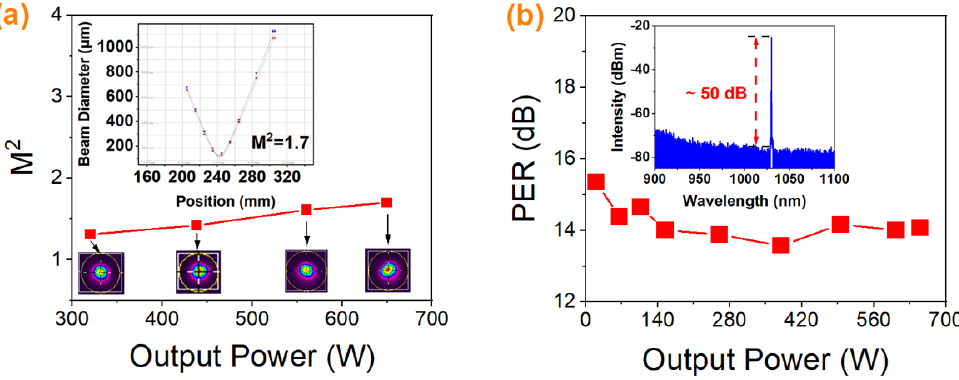
Figure 7. SFFA under hybrid pumping with a power ratio of 1:4.4. ( a ) Measured beam quality and beam profiles at different output powers. Inset: beam quality measurement results at 650 W. ( b ) Measured PER at different output powers. Inset: output optical spectrum at the maximum power within the wavelength range of 900 − 1100 nm.